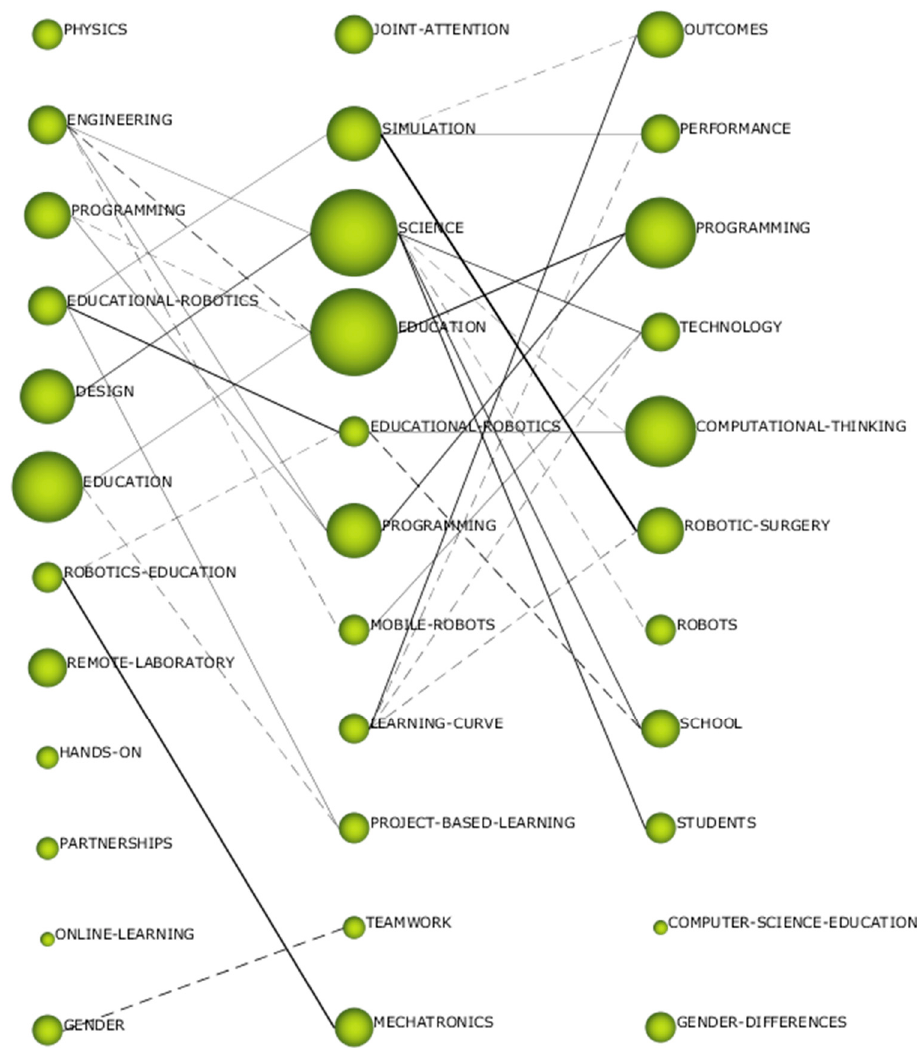
Figure 6. Thematic evolution by h-index.